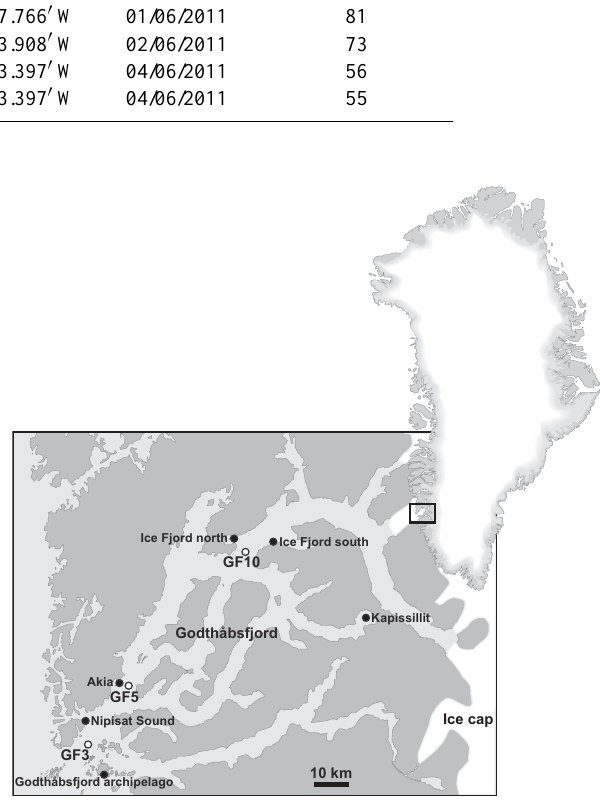
Fig. 1. Map of Godth˚absfjord with locations of shell collections (black circles) and water measurements (white